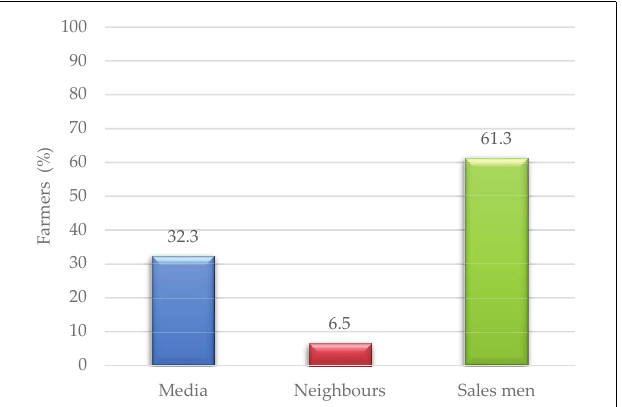
and pigeon peas. Most (83.9%) of the farmers preferred the determinate type of lablab for their production while only 16.1% liked the indeterminate type. Lablab was grown during the long- rain season by a majority of the farmers (93.5%) while 6.5% grew the crop during the short rains. Maturity indices used by most farmers were the pod color (93.5%) while 6.5% used the seed color. During harvesting, a majority of the farmers (90.3%) picked dry pods while 9.7% uprooted the entire plant. Over 80% of the farmers manually threshed their produce while the remaining 19.4% used mechanical methods ( Table 2 ).